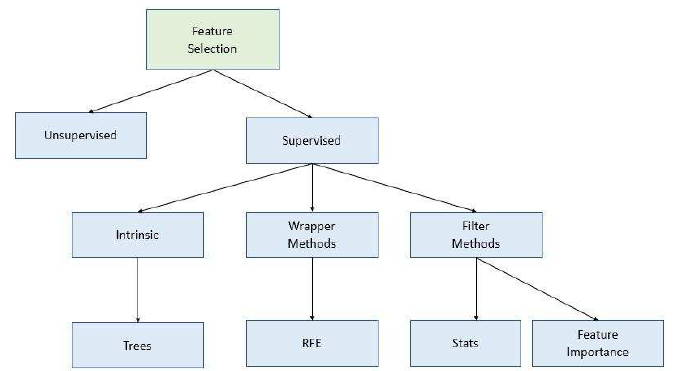
Figure 3. Feature engineering